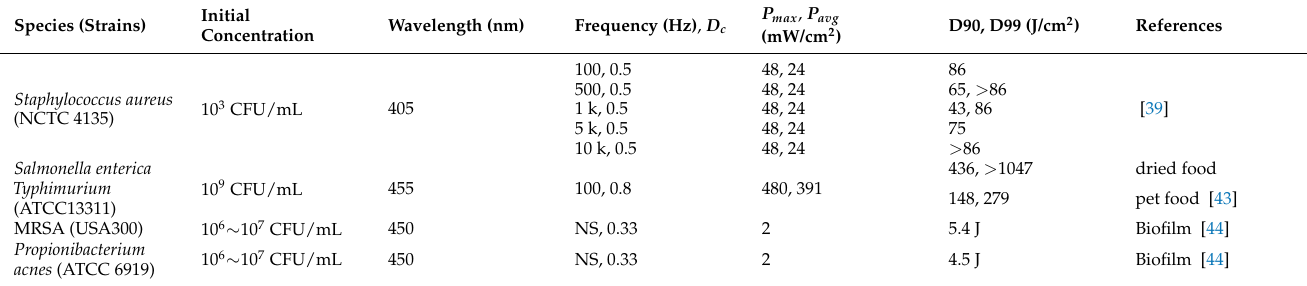
Table 3. Summary of pulsed blue light inactivation of planktonic bacteria ( D c ∈ ( 0,1 ) ) ( D c = 1).